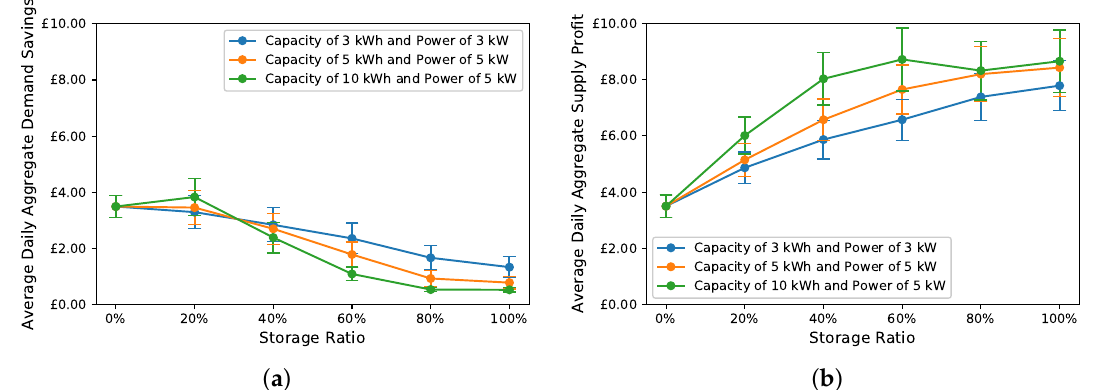
Figure 8. Average daily DS K and SP K for the setting with perfect predictions with storage. The average SP K is more than DS K because flexible agents raise the trading price to gain more profit. That is why as storage ratio increases, SP K increases as well, because prosumers have more flexible energy to offer at higher prices, which also decreases DS K . The error bars represent 95% confidence intervals. ( a ) Average daily DS K . ( b ) Average daily SP K